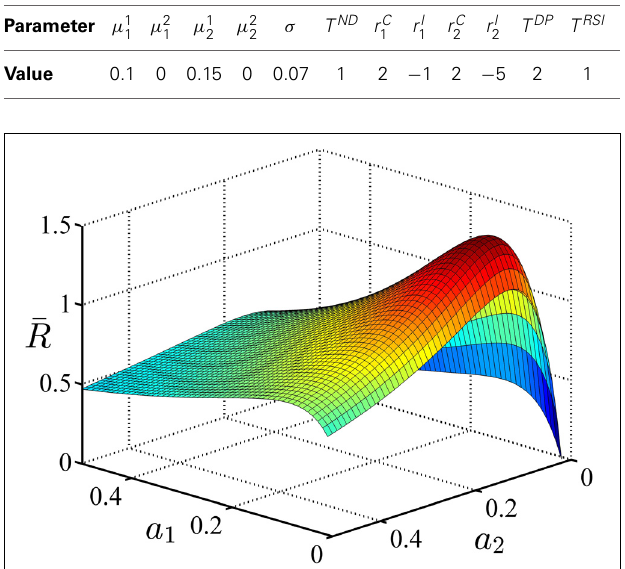
FIGURE 4 | The average reward rate in example 2. In this example, there are two conditions and each trials starts with presentation of a cue associated with these conditions. It is assumed that the subject sets different decision thresholds for each condition. In this figure, the average reward rate is plotted as a function of these decision thresholds. a 1 denotes the decision threshold in condition 1 and a 2 denotes the decision threshold in condition 2. The task parameters are given in Table 3